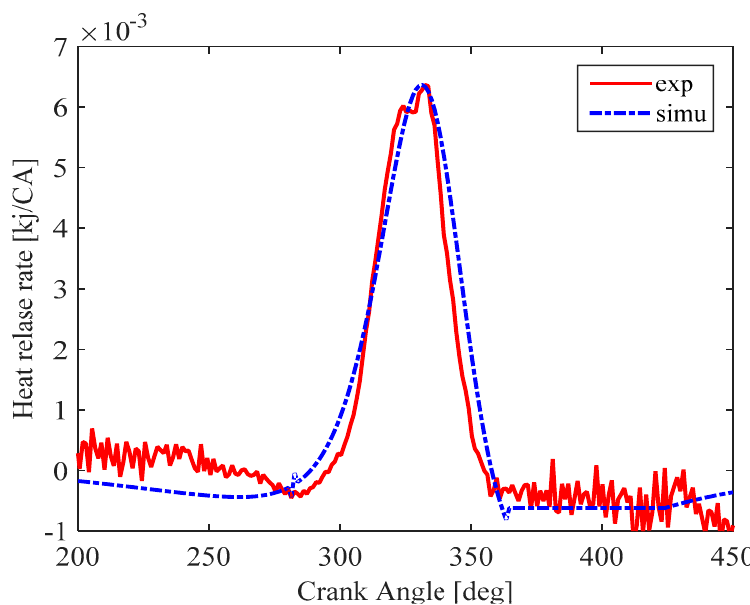
Figure 10. Heat release rate vs. crank angle for the experiments (solid red line) and simulations (dash blue line).